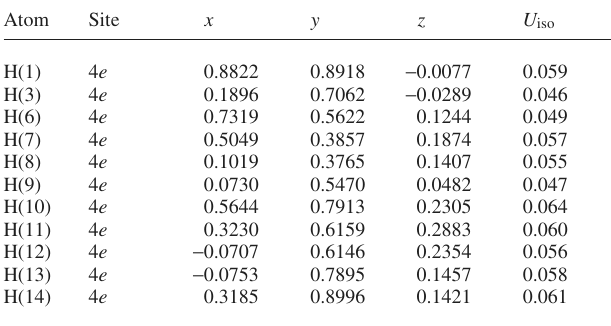
Table 2. Atomic coordinates and displacement parameters (in Å 2 ) .